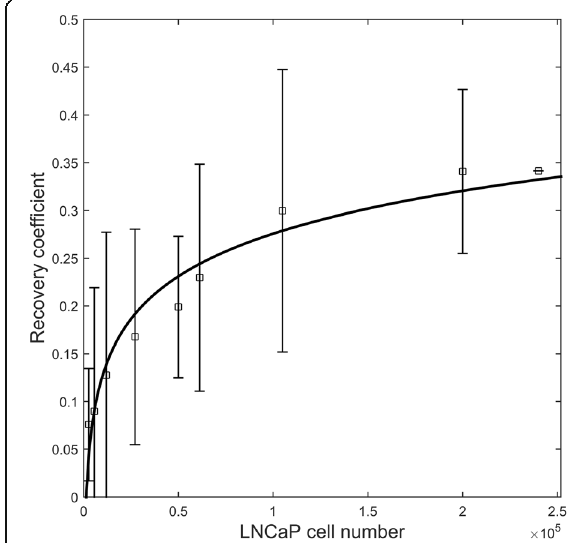
Fig. 4 Recovery coefficient of Ga68-PSMA-11-PET/CT image as a function of number of LNCaP cells disseminated in a pellet of 2 × 10 5 cells (HCT116+LNCaP). The actual activity uptake in the cells was obtained with an automated gamma counter. The error bars indicate standard error